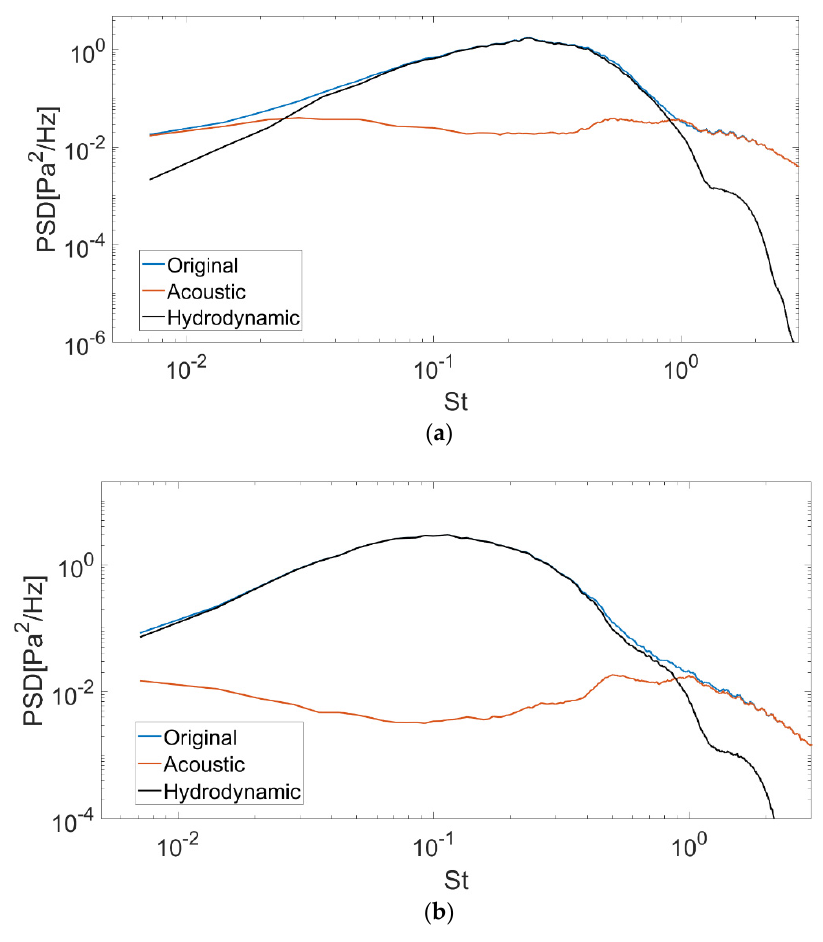
Figure 6. Same as previous plot but at higher M: ( a ) x/D = 3, r/D = 1, M = 0.9; ( b ) x/D = 8, r/D = 1, M = 0.9.